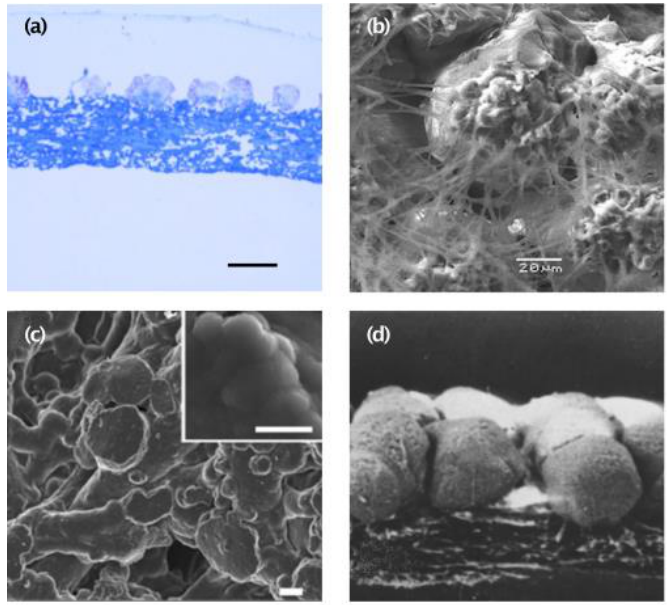
Figure 4. ( a ) Optical microscopy photography collected seven hours post ovulation (p.o.). Mineral-